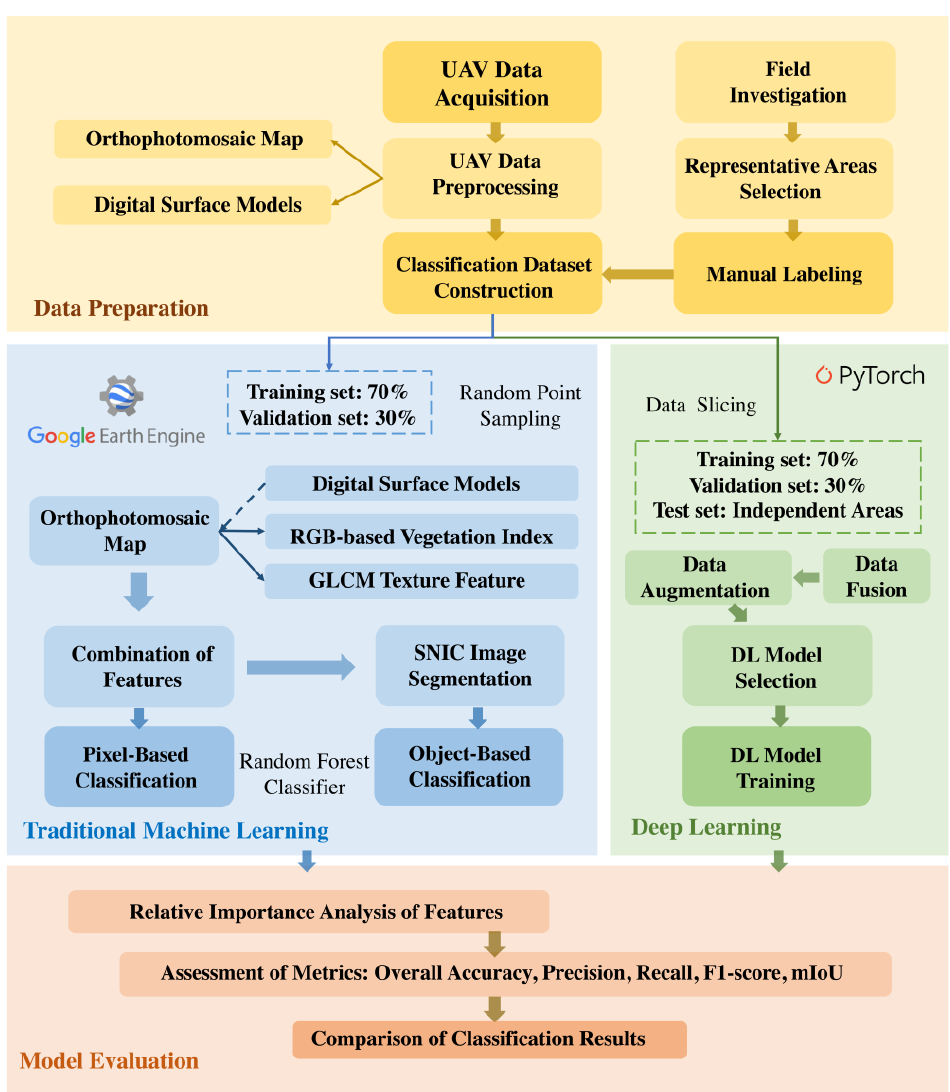
Figure 2. Flowchart of this study. The flow of this study can be divided into 4 stages, which are (1) data preparation, (2) vegetation classification based on traditional ML, (3) vegetation classification based on DL, and (4) model evaluation.